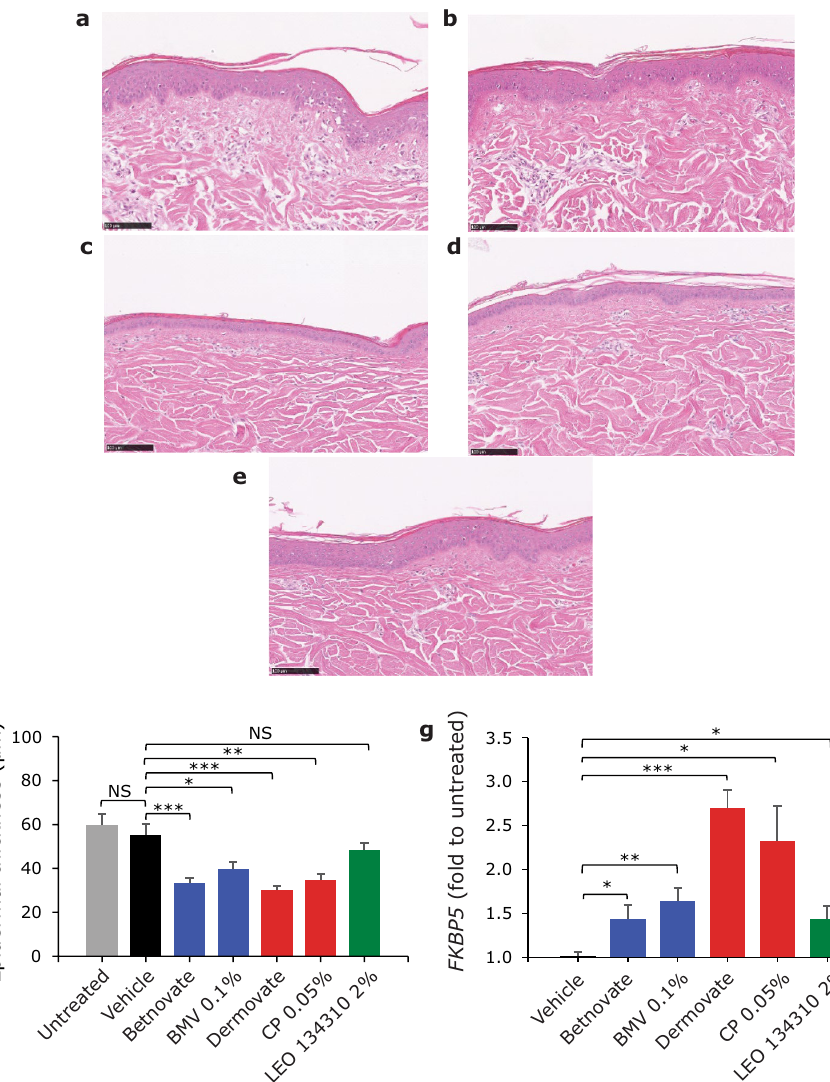
Figure 2. LEO 134310 does not induce skin atrophy in minipigs. H&E staining of minipig skin biopsy samples from untreated skin ( a ), test fields treated with LEO vehicle ( b ), Dermovate cream 0.05% CP ( c ), Betnovate cream 0.1% BMV ( d ), and LEO 134310 2% ( e ). The bar represents 100 µm. Epidermal thickness in skin biopsies from minipigs after 4 weeks treatment ( f ) (n = 5). Statistical significance was determined by one-way ANOVA with Dunnett’s multiple comparisons test versus vehicle. *p < 0.05; **p < 0.01; ***p < 0.001; NS: not significant. Fold changes of FKBP5 expression in relation untreated control, measured by qRT-PCR in skin biopsies from minipigs treated for 4 weeks ( g ) (n = 5). The differences were modelled in a paired manner applying a linear mixed effects model, with Dunnett’s post hoc testing (*p < 0.05; **p < 0.01; ***p < 0.001). Error bars represent standard errors of the paired